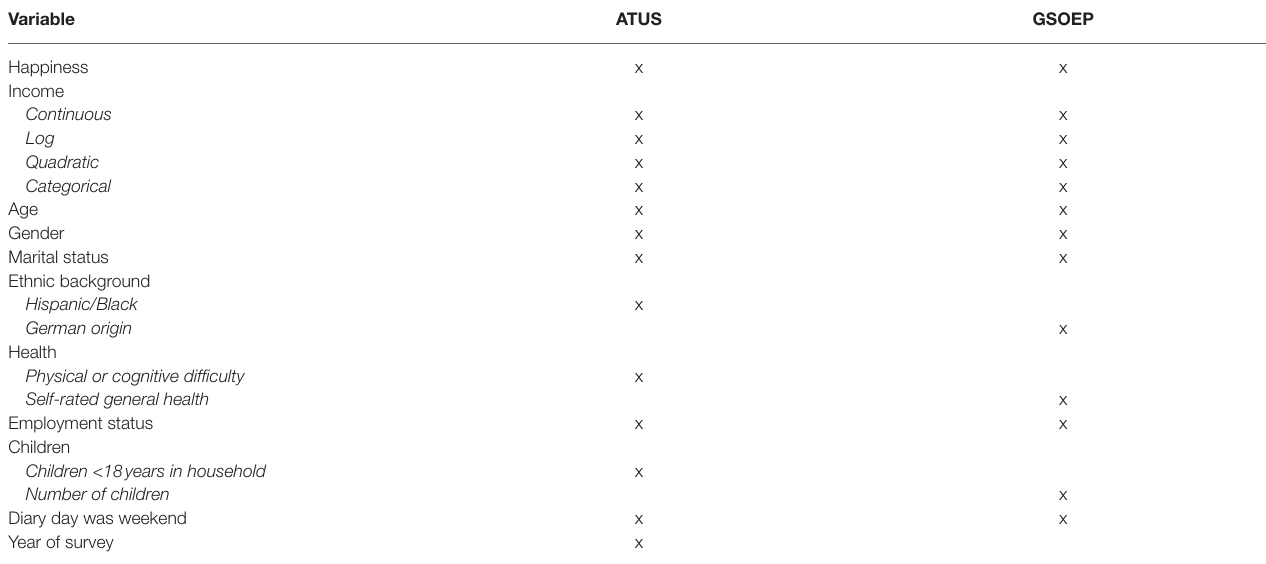
TABLE 3 | List of variables used in analyses in ATUS and GSOEP.